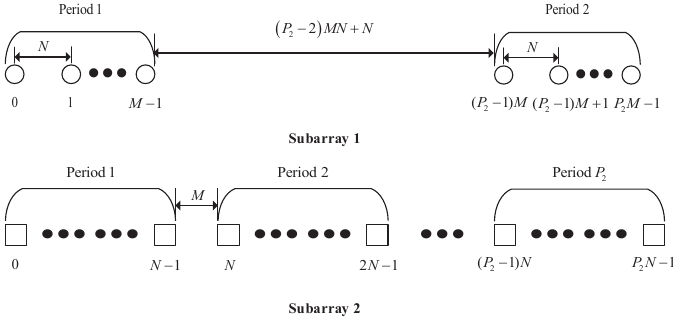
Figure 4. The diff–sum coprime array with multiperiod subarrays.